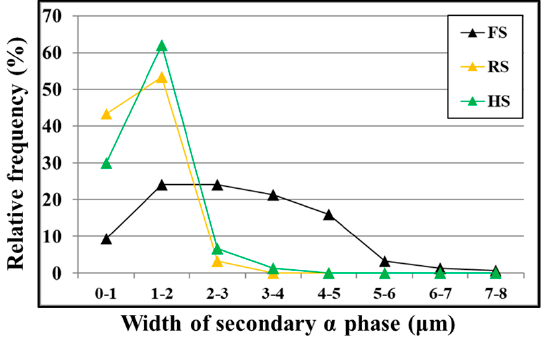
Figure 5. Diameter distributions of α p grains in longitudinal sections obtained from FS, RS, and HS.